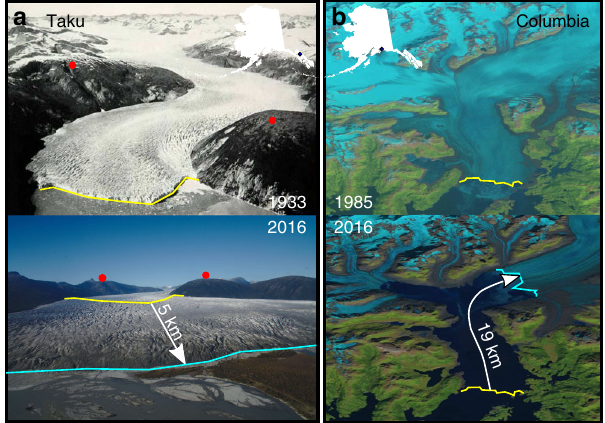
Fig. 1 Advancing versus retreating glaciers in coastal Alaska. a Taku Glacier, which began advancing around 1850, is in the advance stage of the tidewater glacier cycle ( TGC ) (note the image obliquity). Image shows the terminus in 1933 ( yellow line ), when the glacier still possessed a vigorous calving front, versus 2016, where the glacier now terminates subaerially on glacio fl uvial sediment ( blue line ). Red dots are the same location in each image. b Columbia Glacier, which began retreating in the mid 1980s, is in the dynamic retreat phase of the TGC. The yellow line is the terminus position in August 1985, near its maximum, whereas the blue line is the terminus position as of October 2016. Photo Credits: top left : U.S. Navy, 1929. Taku Glacier: From the Glacier Photograph Collection. Boulder, Colorado USA: National Snow and Ice Data Center. Digital media. Bottom left : M. Truffer. Top right : Landsat 7, data available from the U.S. Geological Survey. Bottom right : Landsat 8, Data available from the